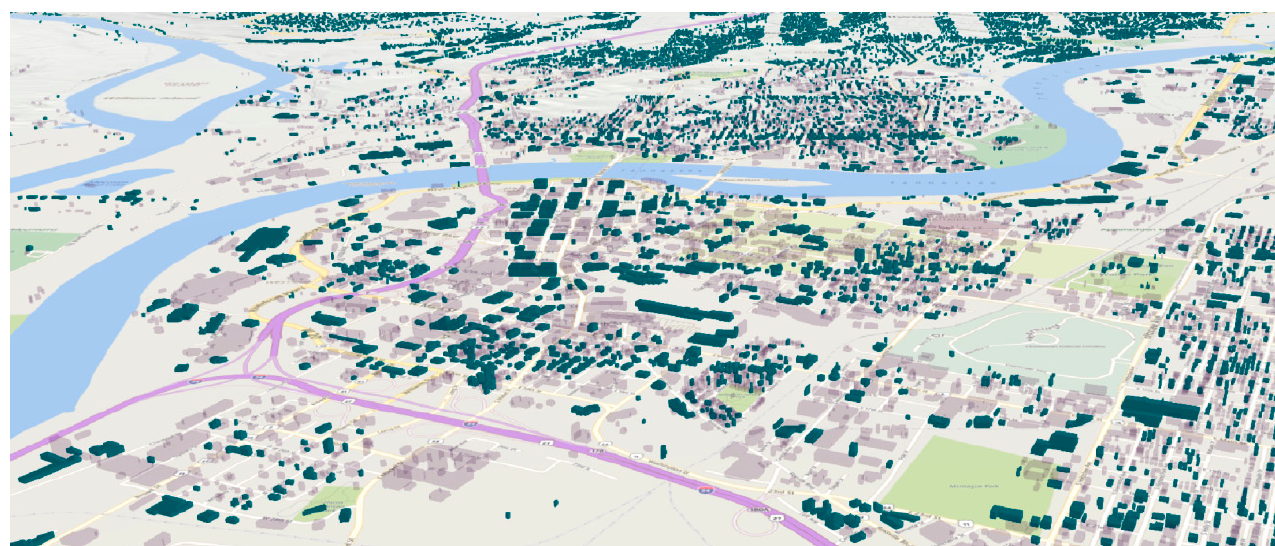
Figure 1. All 178,337 buildings and simulation results can be searched, selected, and visualized using flexible regular expressions that can query and combine any number of data fields (bit.ly/virtual_epb).